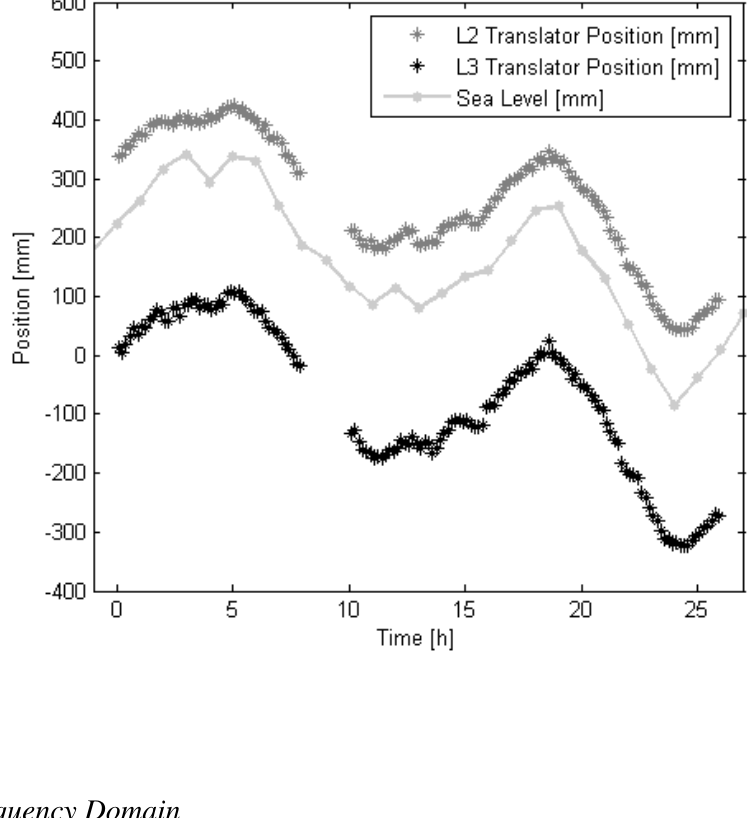
Figure 2. Comparison between the sea level at Smögen (courtesy of SMHI) and the position of the translator for L2 and L3. Each point in the figure represents the 10 min average of the translator position. It can be seen that the translator is in phase with the sea